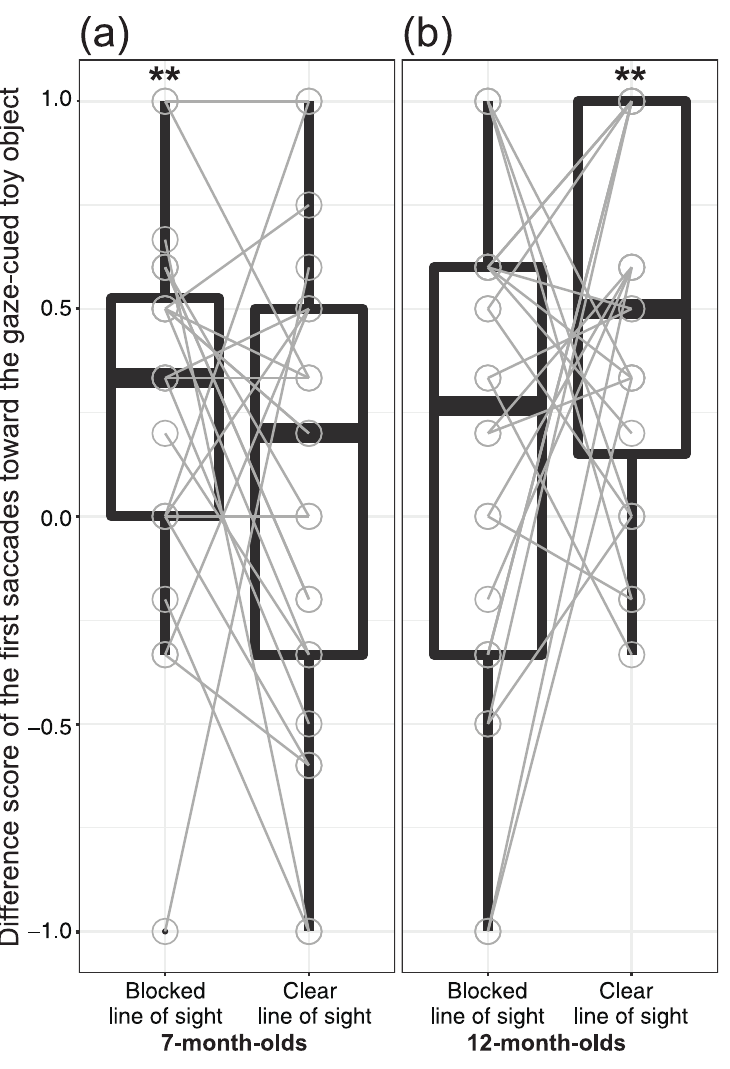
Fig 2. Difference score of the first saccades toward the gaze-cued toy object for the Blocked Line of Sight and Clear Line of Sight Conditions. Results are shown for the (a) 7-month-old infants and (b) 12-month-old infants. The central mark indicates the median, and the bottom and top edges of the box indicate the 25th and 75th percentiles, respectively. The upper whisker (vertical line) extends from the third quartile to the largest value. However, this is no further than 1.5 interquartile ranges from the third quartile. The lower whisker extends from the 25th percentile down to the smallest value. This goes no further than 1.5 interquartile ranges from the first quartile. �� p < 0.01.